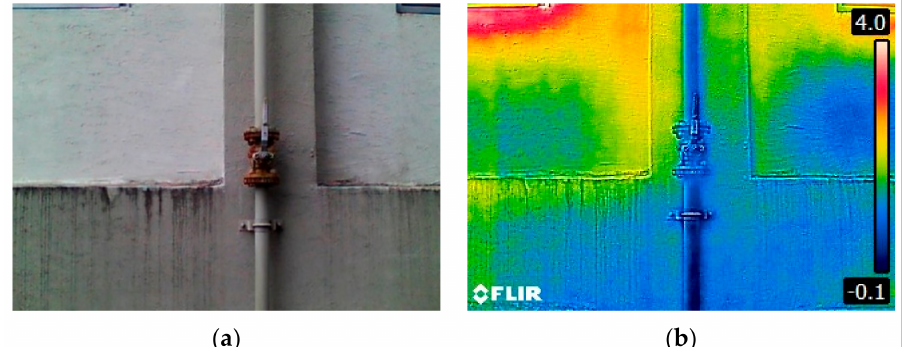
Figure 1. ( a ) Gas pipe image using an ordinary camera; ( b ) gas pipe image using a thermal